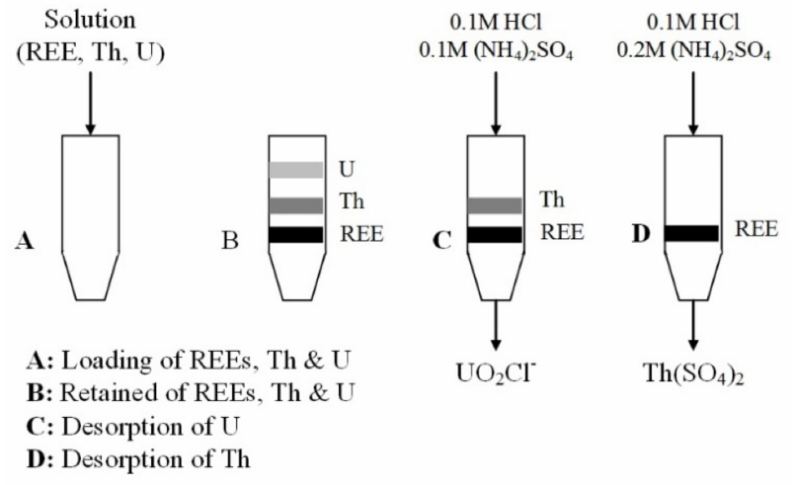
Figure 7. Cation exchange extraction with Dionex Ion Pac CS5